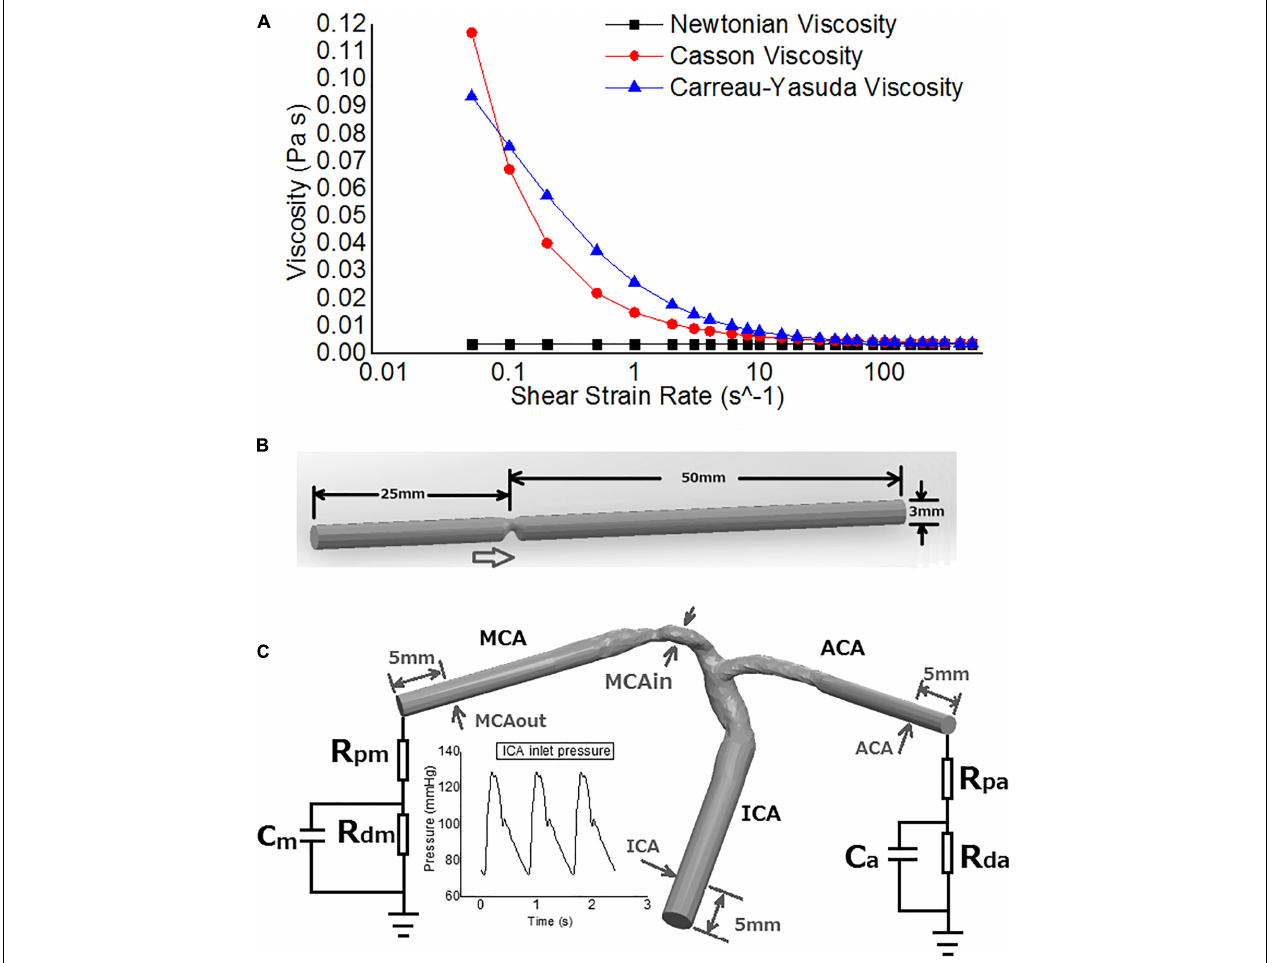
FIGURE 1 | The rheological and geometrical models. (A) Different rheologic models. Viscosity values are derived in varied shear strain rates. The shear strain rate axis is logarithmic. (B) Geometry of the virtual arterial stenosis model with an eccentric 75% stenosis in area (upper). (C) The transient MCA stenosis (about 55% in diameter and 74% in area at the throat) model with internal carotid artery (ICA)-middle cerebral artery (MCA)-anterior cerebral artery (ACA) branches (lower). Boundary conditions: pressure on ICA inlet, Windkessel models on ACA and MCA outlets. The arrows point to the positions of pressure measurement.